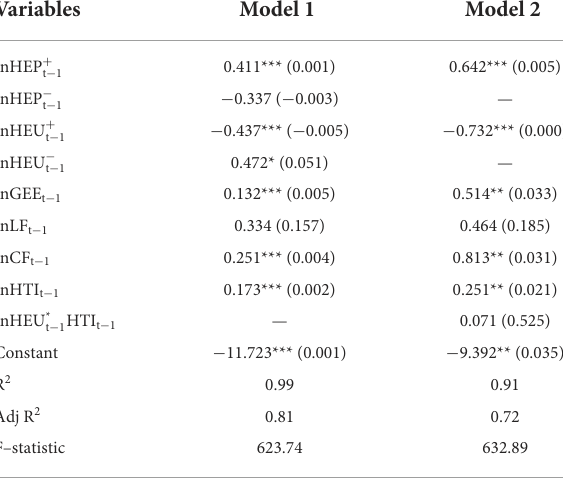
TABLE 5 Long-term variable elasticity results of the NARDL approach.